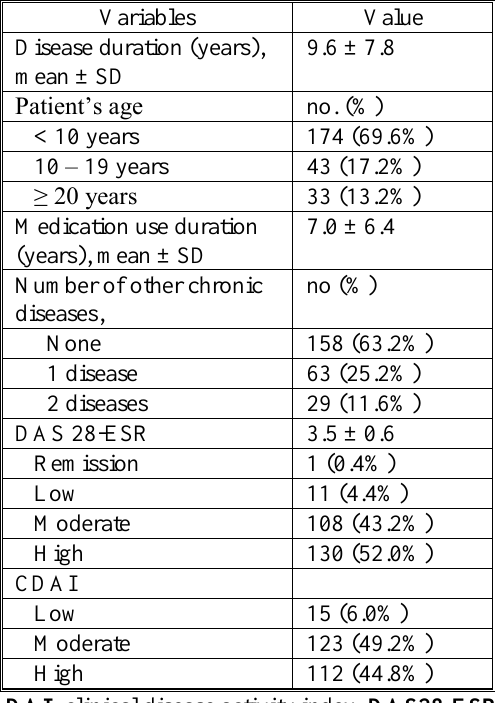
Table 2. Disease characteristics of the patients